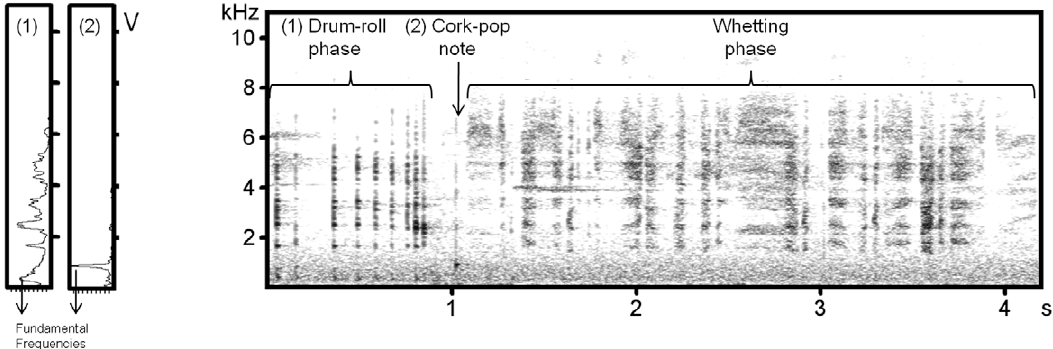
Figure 2. Spectrogram and mean spectra of Capercaillie song. Example of a spectrogram of a Capercaillie song (right) and mean spectra of the first click of the drum-roll phase (1) and of the cork-pop note (2) (left). Arrows indicate the spectral parameters taken into account for this study (fundamental frequency of the drum-roll and of the cork-pop). In the time domain, we measured the duration of the drum-roll and whetting phase. with a Poisson distribution of errors, GLM, all Z , 0.32, P . 0.71,